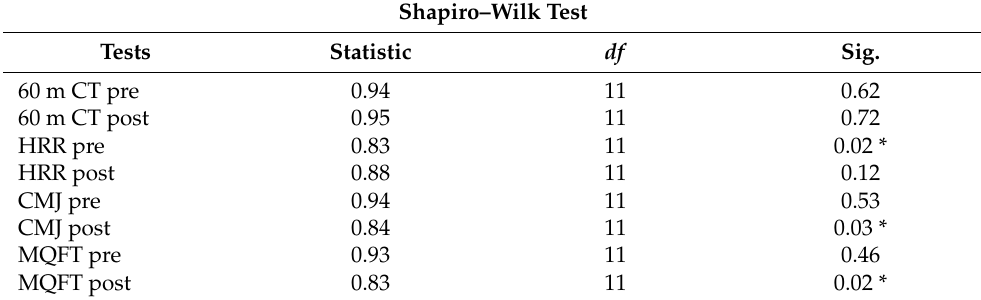
Table 1. Test of normality.